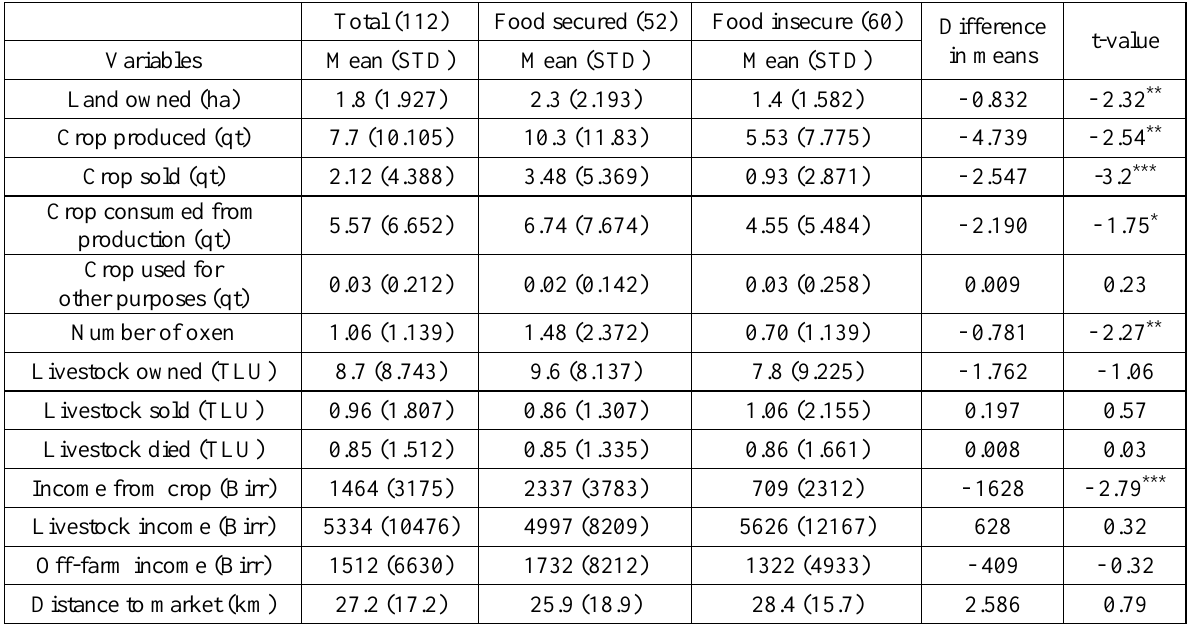
Table 3. Descriptive analysis of asset ownership, income and access to market of the sample household for the continuous